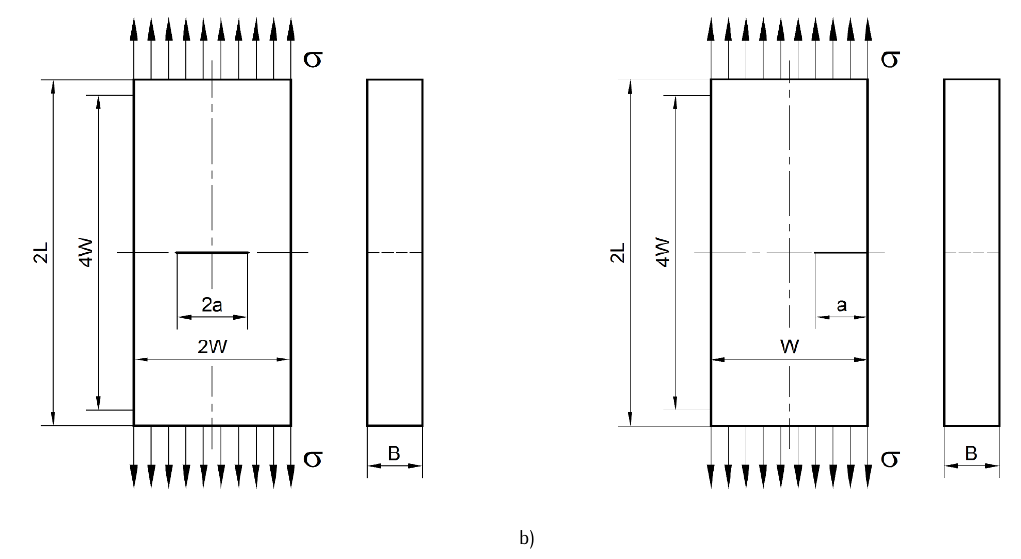
Figure 5. The comparison of the J - Q trajectories (a) and a) Centre cracked plate in tension (CC(T)); b) Single-edge notched plate in tension (SEN(T)).